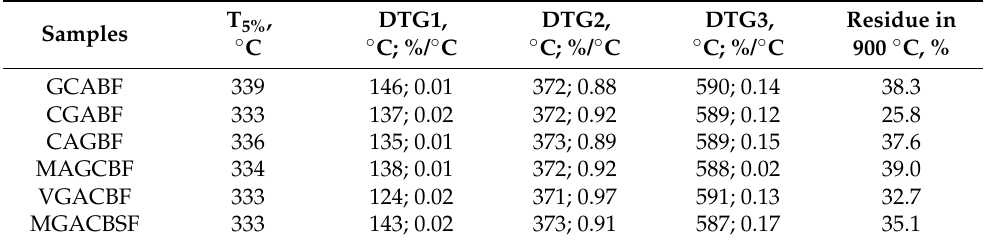
Table 2. TG and DTG data of unmodified UP and resin with APP and LHP.